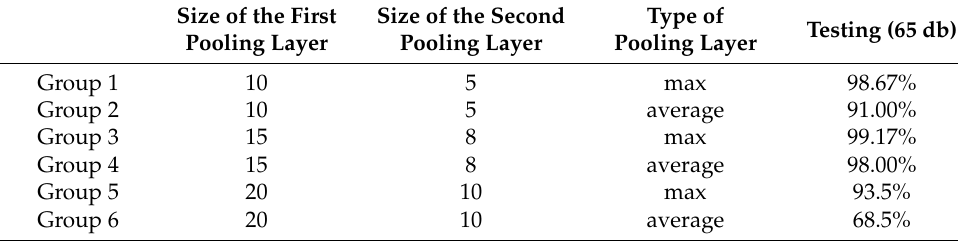
Table 4. Results of different Pooling sizes.